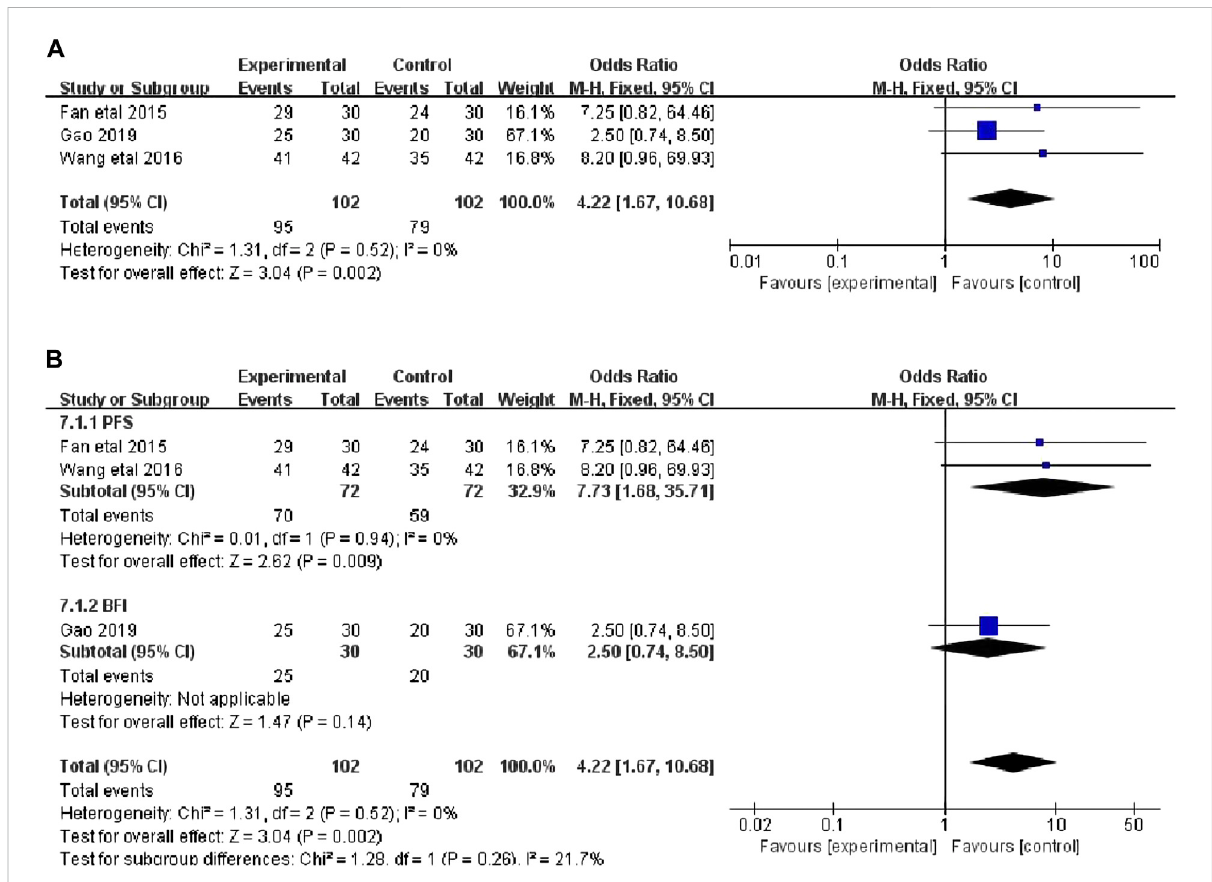
FIGURE 3 (A) TheforestplotoftotalscoresofCRFdichotomousdata. (B)